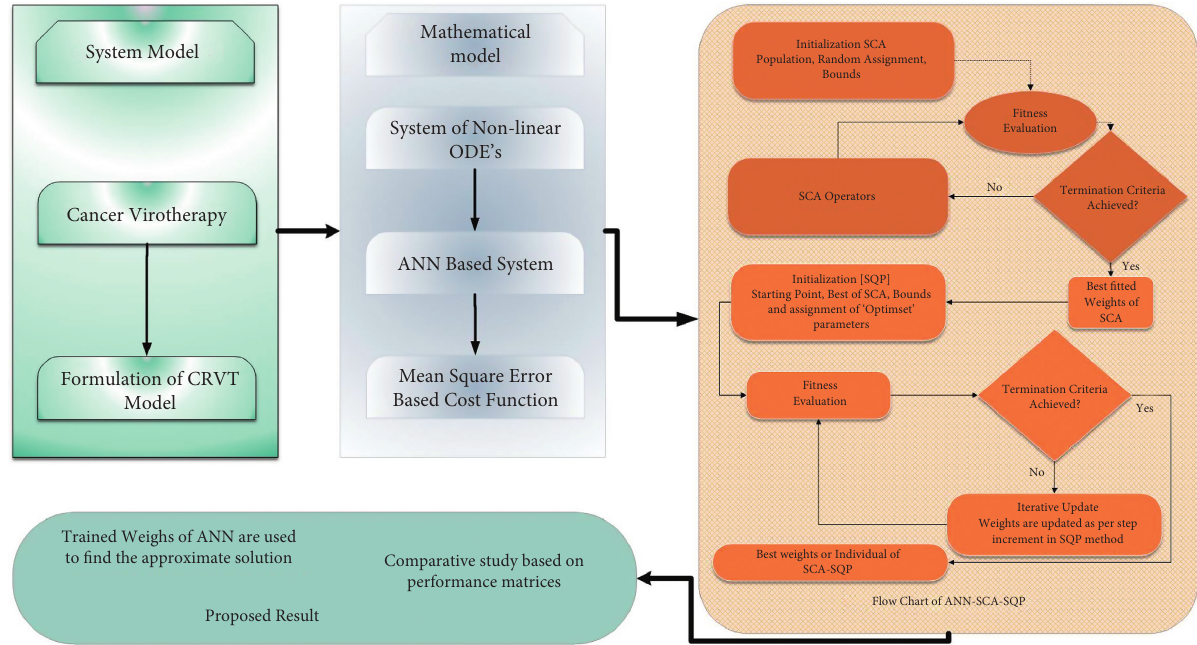
Figure 1: The flow chart of the proposed methodology ANN-SCA-SQP. Here, SCA generates a number of random solutions and evaluates it on its fitness; then, it is provided to SQP as an initial point for further refinement. The fittest weights are obtained for the solution of